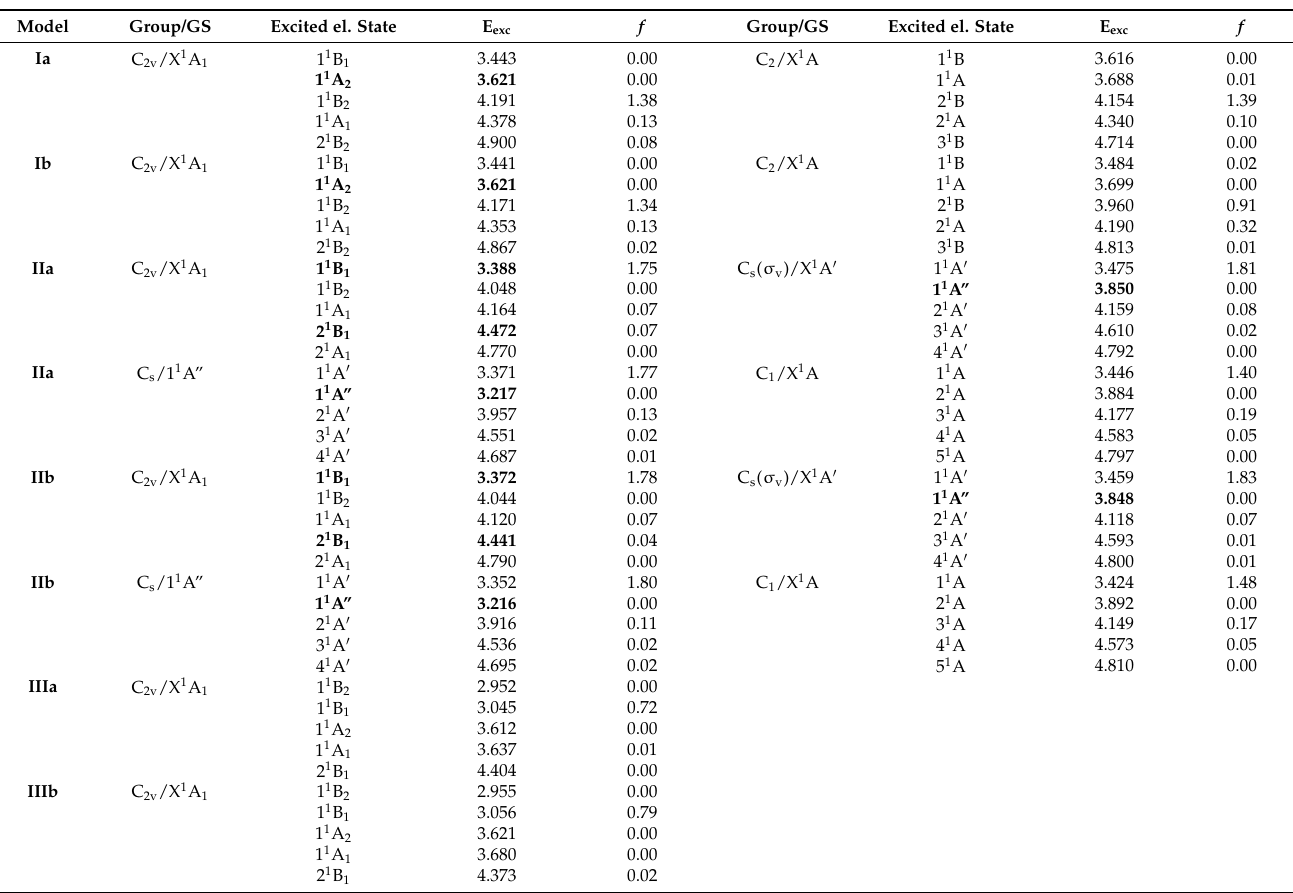
Table 2. Symmetry group/electronic ground state (GS), excitation energies ( E exc ) in eV and oscillator strengths ( f ) in atomic units for the corresponding electron transitions of the excited states for the optimized structures in relevant electron states (PJT active electron states in